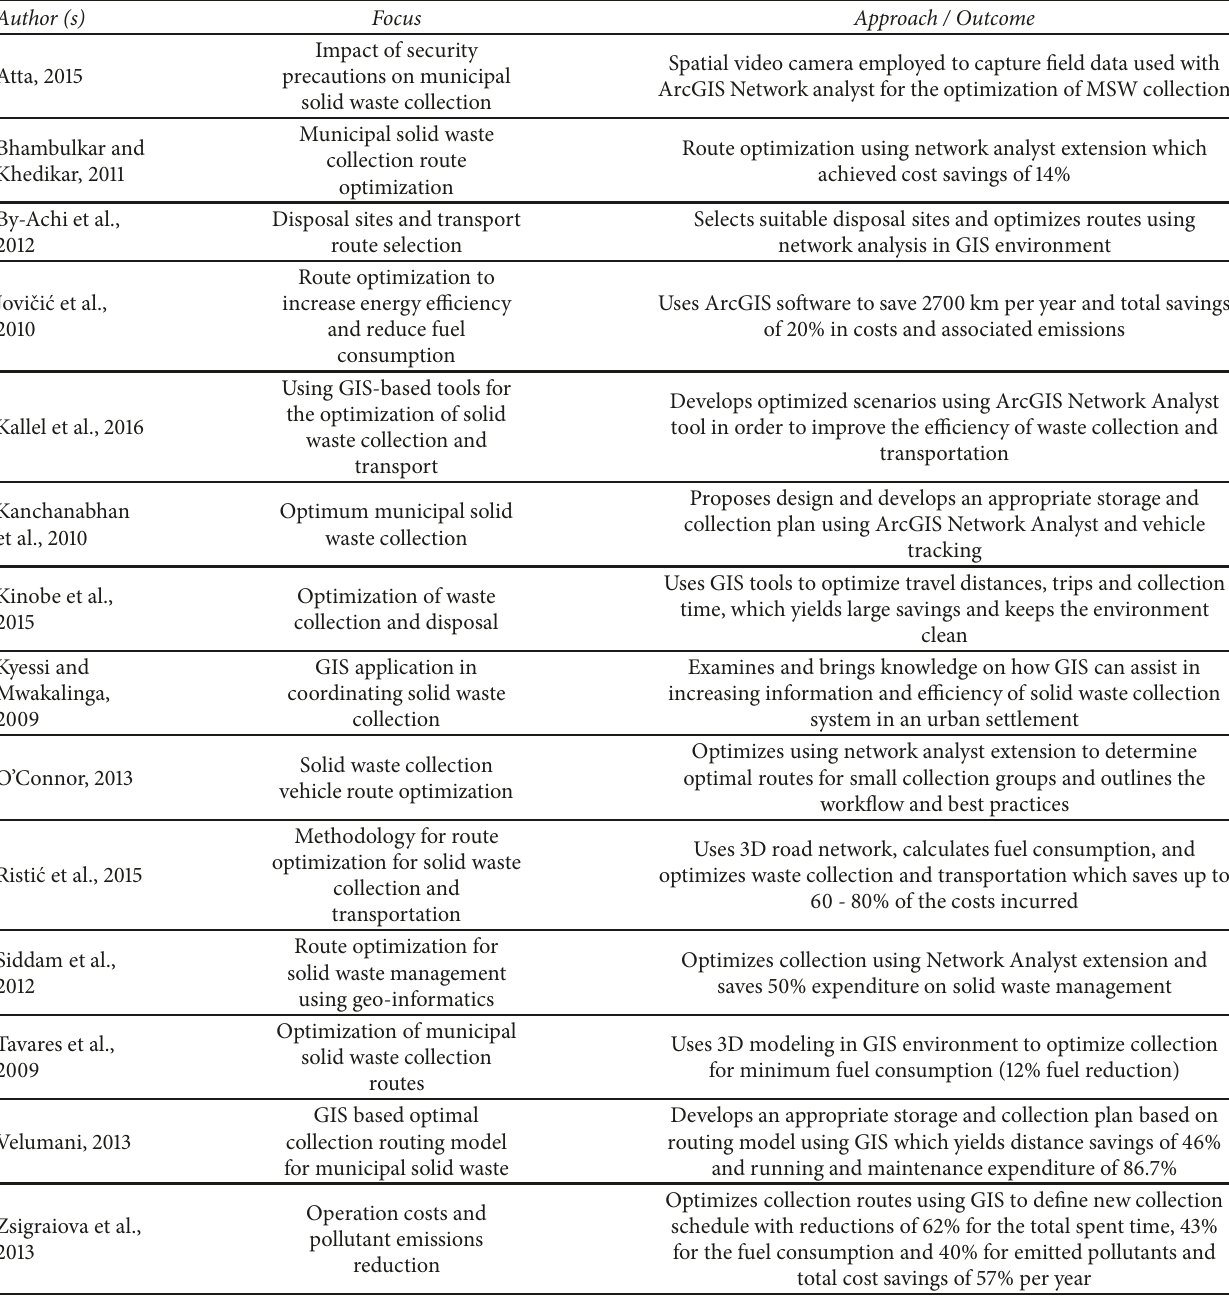
Table 2: Studies on routing for solid waste collection using GIS (nonexhaustive